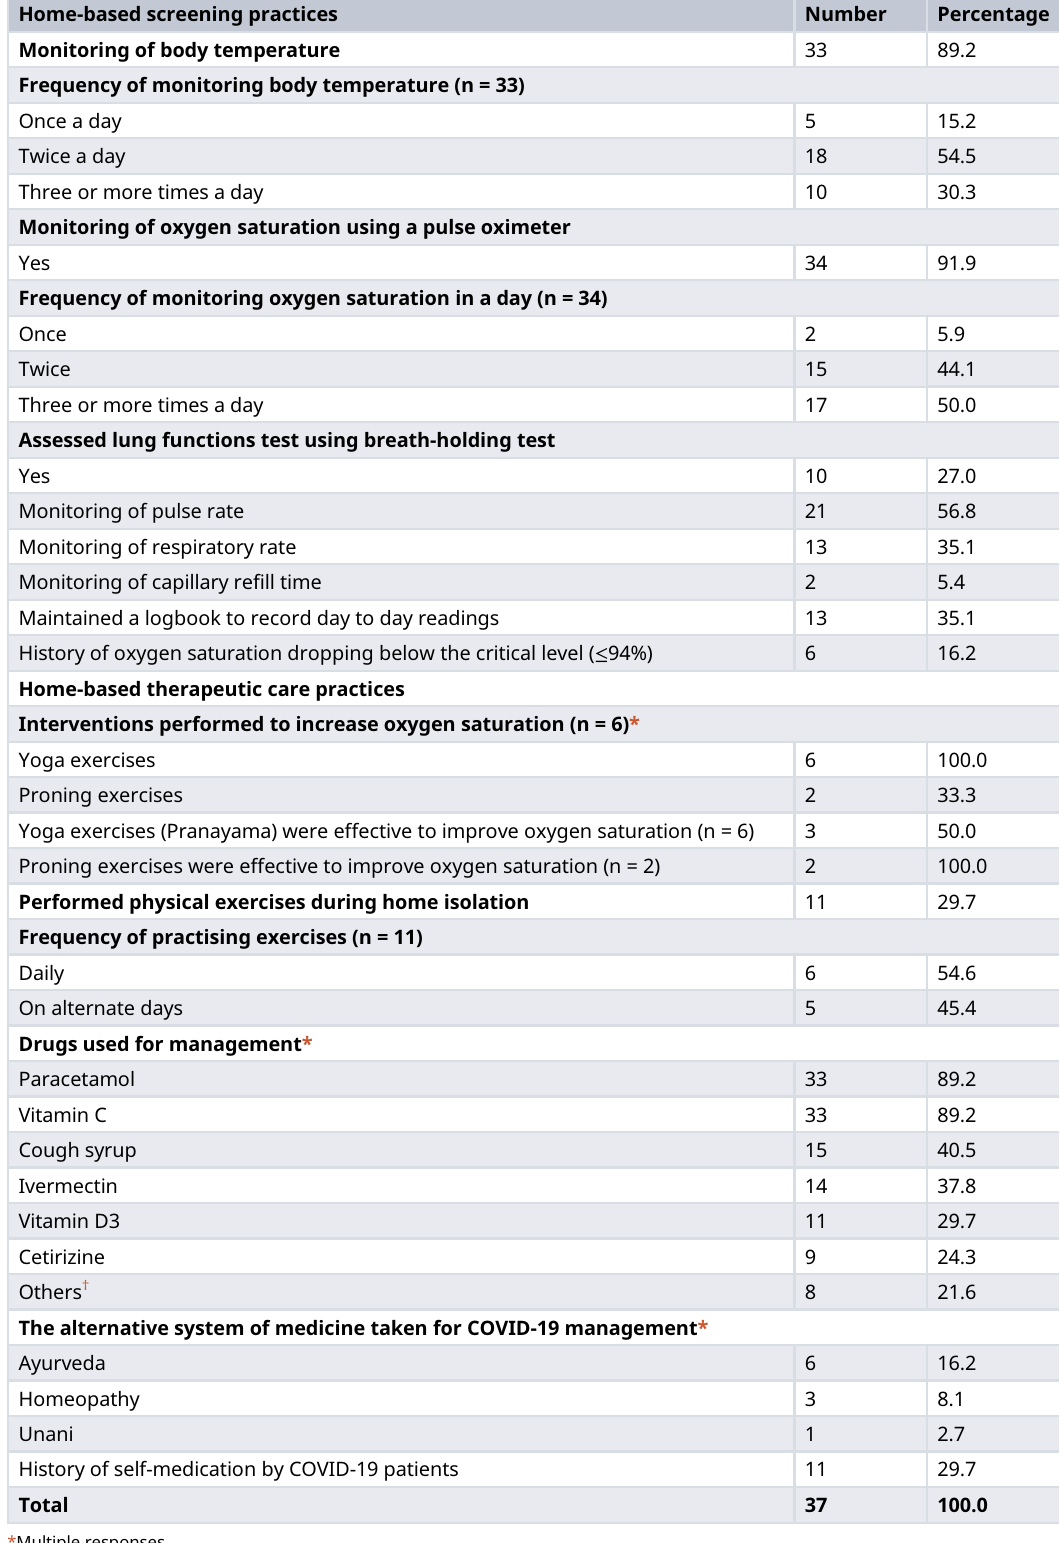
Table 2. Home-based screening and therapeutic care practices among participants who were diagnosedwith COVID-19. Home-based screening